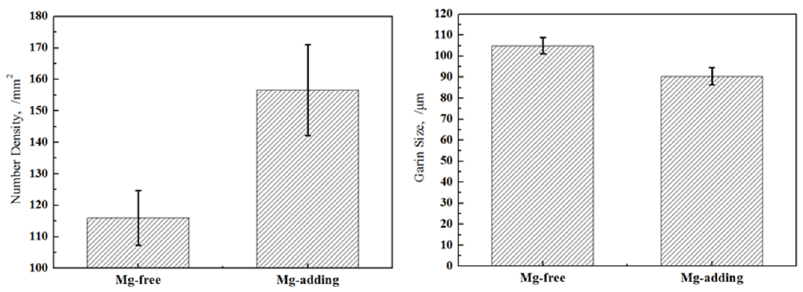
Figure 11. Comparison of number density and size of grains of as-cast structure before and after magnesium treatment.